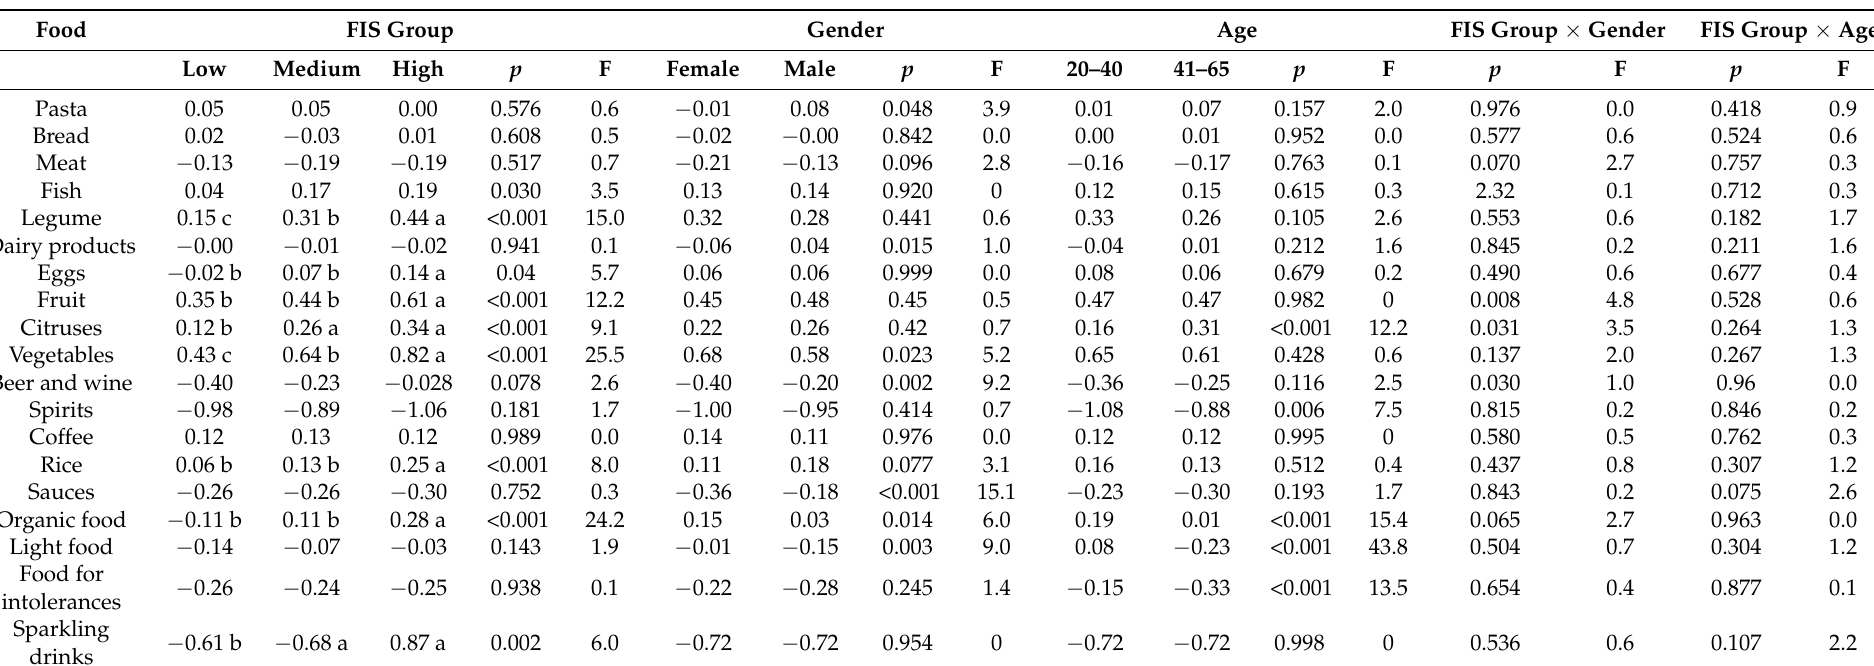
Table 6. Three-way ANOVA model on food variation consumption in the COVID-19 period. FIS group, gender, and age were used as fixed factors with